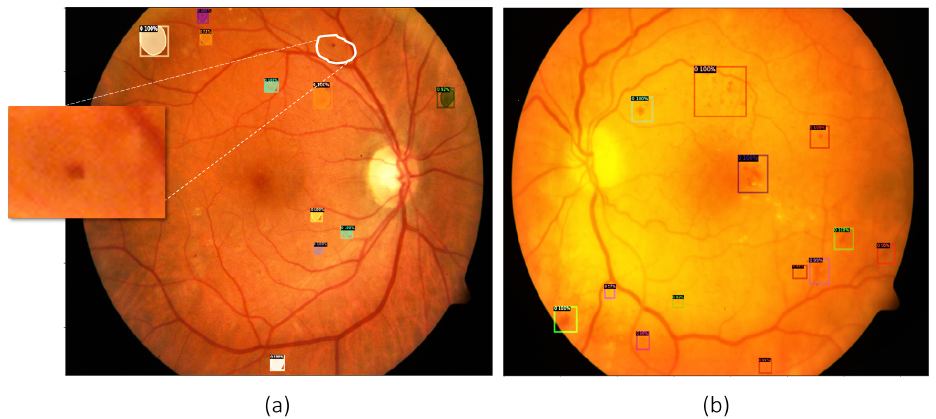
Figure 8. Results of hemorrhage detection and segmentation from baseline models. ( a ) Hemorrhage detection indicating early stages of DR without DME. The marked area on the top right represents a failure in identification. ( b ) Hemorrhage detection indicating both DR and a clear case of